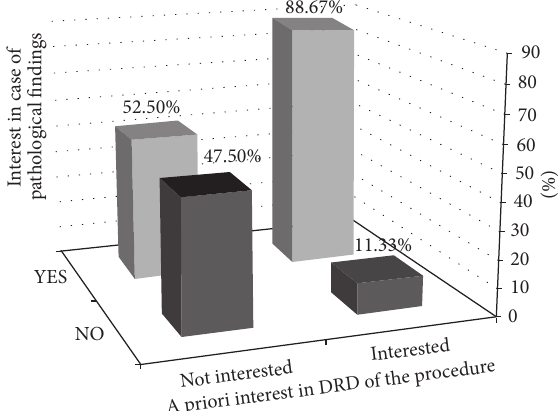
Figure 3: A priori interest of patients in DRD, and their interest or lack of interest in case of pathological findings.